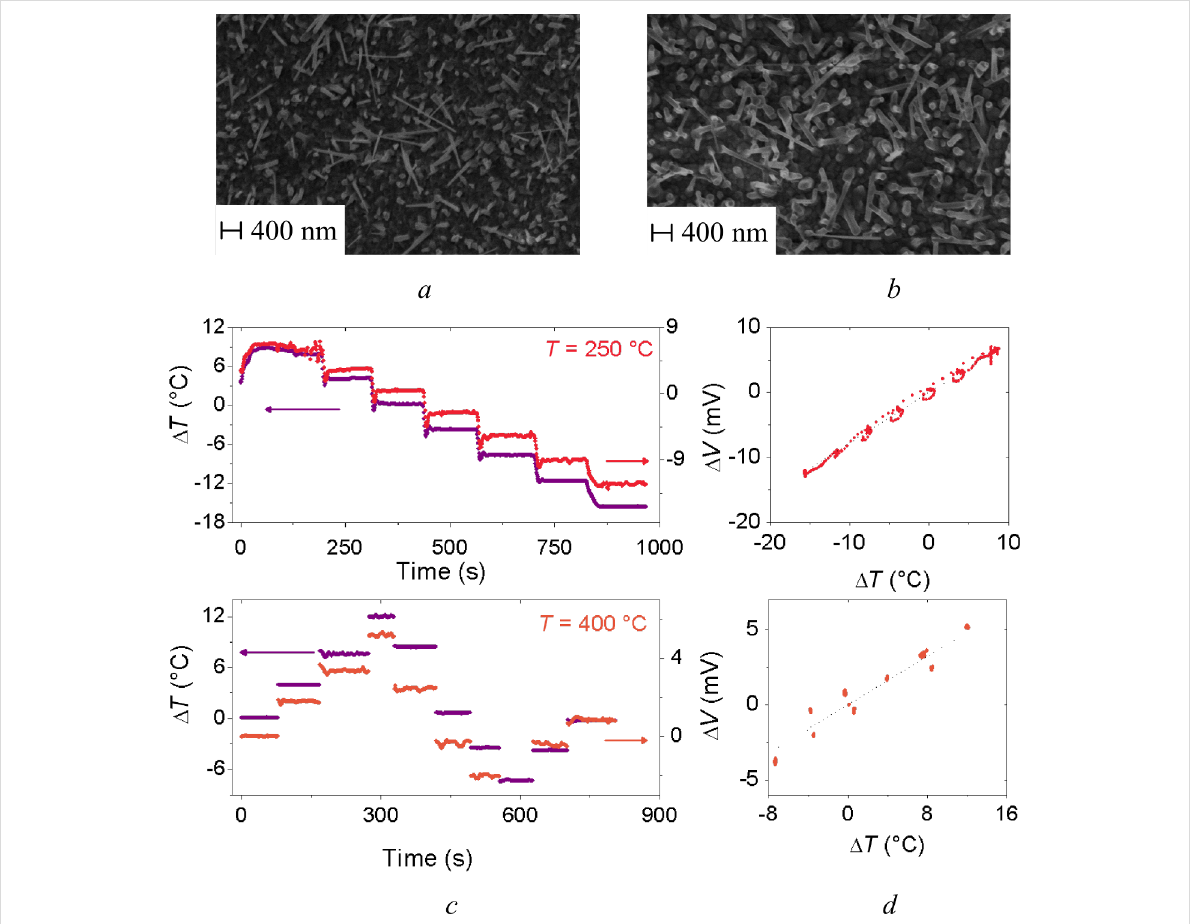
Figure 2: SEM images of CuO nanowires fabricated at (a) 250 °C and (b) 400 °C. (c) Dependence of the applied temperature difference Δ T and the thermoelectric voltage Δ V and (d) the generated voltage Δ V versus the applied temperature difference Δ T across the fabricated CuO samples.